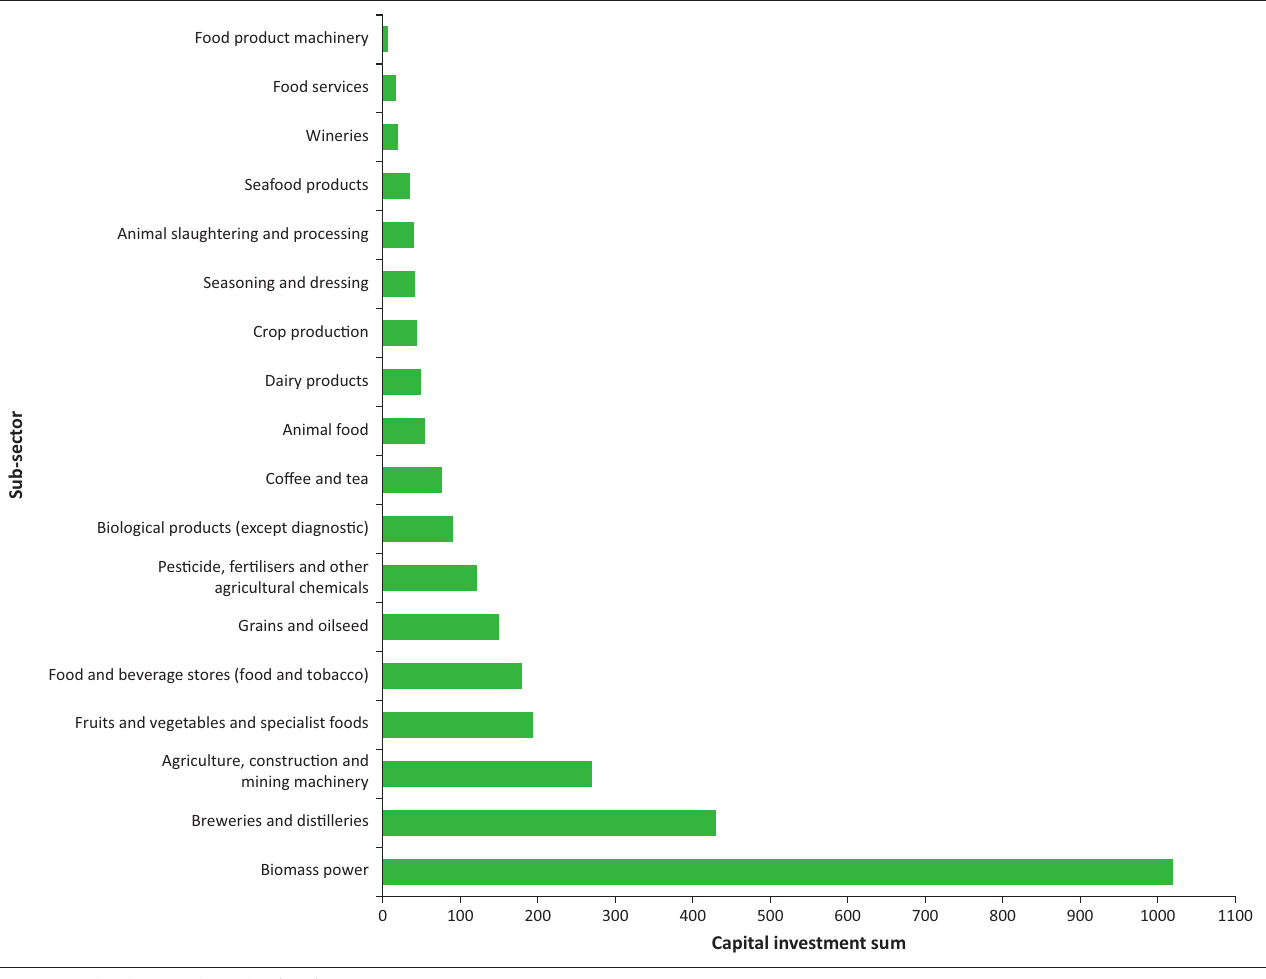
TABLE 1: Agricultural foreign direct investment inflows to South Africa by industry activity, 2003–2014.